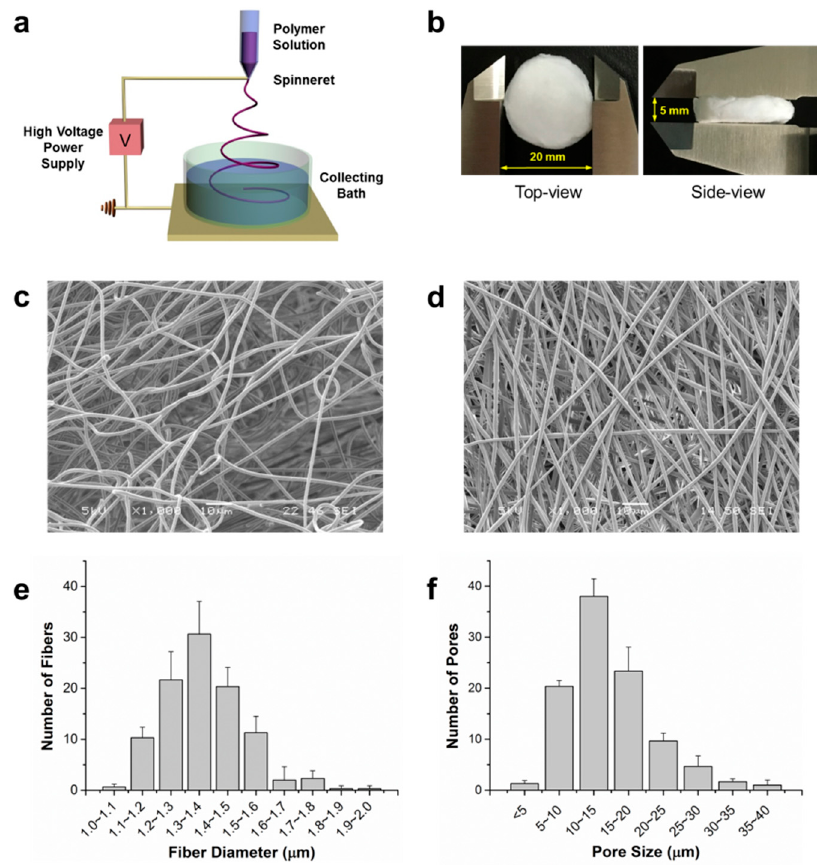
Figure 1. ( a ) Illustration of liquid-collecting electrospinning setups; ( b ) Relative shape and size of spongiform fibrous scaffolds; ( c ) Scanning electron microscopy (SEM) characterization of electrospun scaffolds collected from liquid bath and ( d ) conventional flat platform; ( e ) Distribution of fiber diameter and ( f ) pore size within 3D electrospun fibrous scaffolds. One hundred measurements of fiber diameter and pore size were randomly made from each scaffold; n = 3.